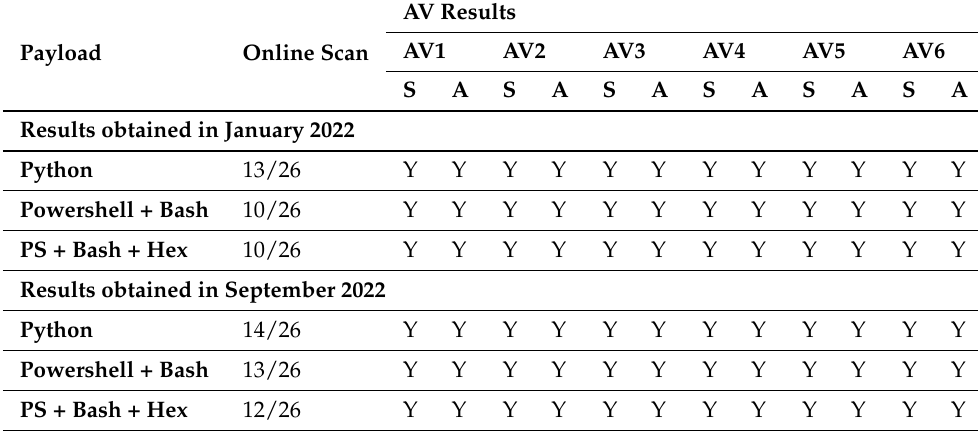
Table 4. Veil-Evasion